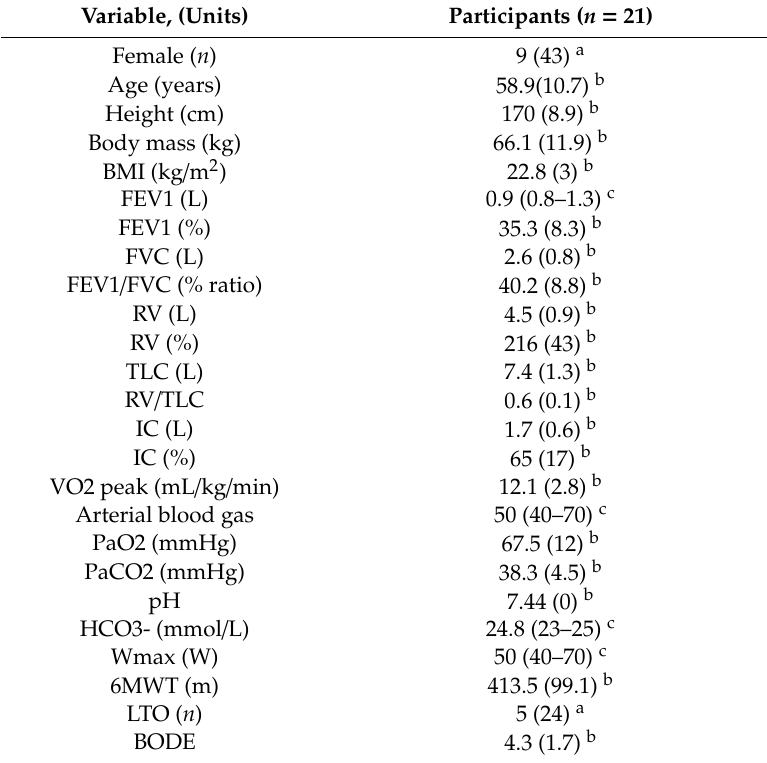
Table 1. Characteristics of the